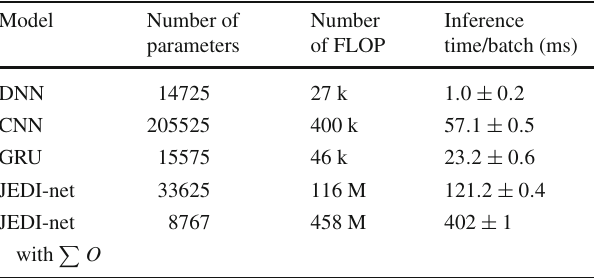
Table 4 Resource comparison across models. The quoted number of parameters refers only to the trainable parameters for each model. The inference time is measured by applying the model to batches of 1000 events100times:the50%medianquantileisquotedascentralvalueand the 10%-90% semi-distance is quoted as the uncertainty. The GPU used isanNVIDIAGTX1080with8GBmemory,mountedonacommercial desktop with an Intel Xeon CPU, operating at a frequency of 2.60GHz. Thetestswereexecutedin Python